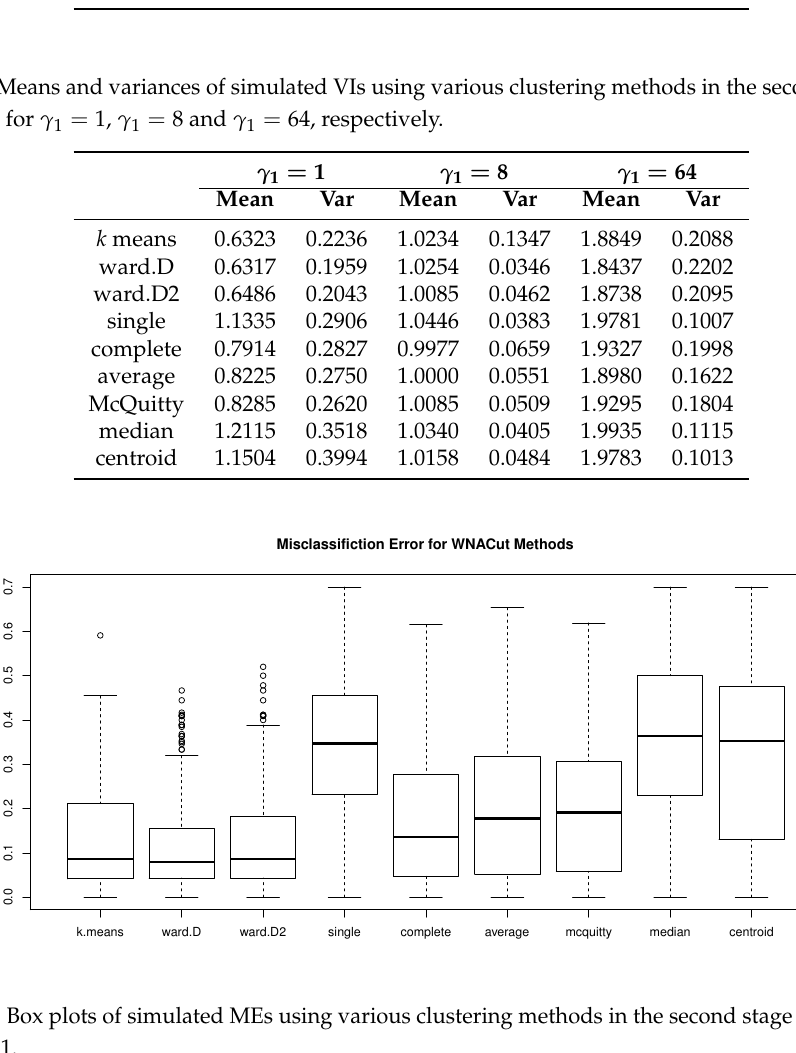
Figure 1. Box plots of simulated MEs using various clustering methods in the second stage of WNACut for γ 1 =